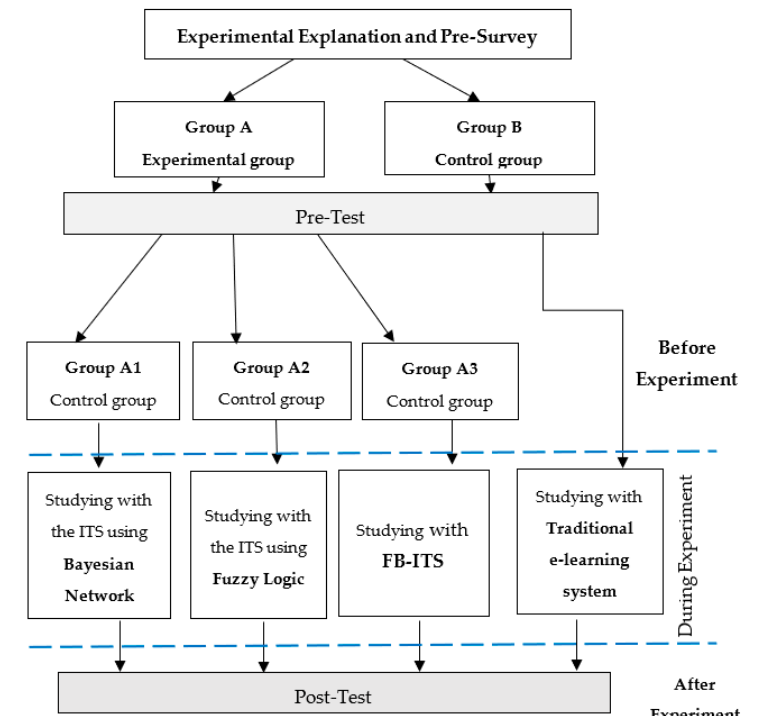
Figure 6. The Experimental Design.